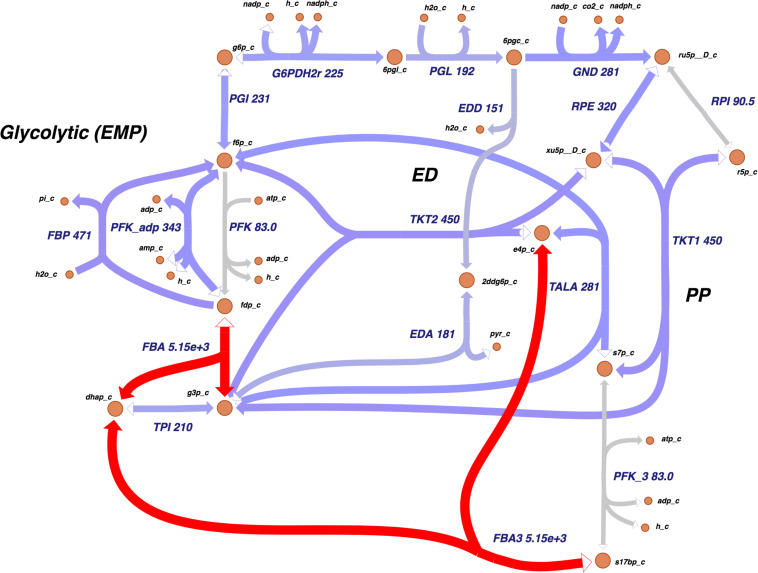
The carbohydrate utilization pathways of Xpm show a high activity at the transcriptional level. Transcriptomic data showed that Xpm has a high activity in the flux balance analysis (gene 1185660.4.peg.3367) and FBA3 (gene 1185660.4.peg.3367) reactions. The data of Xpm CIO151 EV are shown, but similar results were found for Xpm CIO151 ΔrpfCGH-EV. The levels of transcription are shown next to the name of the reaction. Transcriptomic abundances were mapped into Escher maps. The purple color in the maps corresponds to low abundance and the red color to high abundance. The median of the transcript abundances (FPKM) defined the middle point of coloring (between red and purple). Therefore, values below the median are colored purple and those above the median are colored red. When in the reaction rule two or more genes are strictly necessary (AND Boolean rule), the mean of the abundance was calculated. The thickness of the lines is proportional to the abundance of the transcripts involved in the given reaction. Entner–Doudoroff (ED), pentose-phosphate (PP), and Embden–Meyerhof–Parnas (EMP). Constructed in Escher (King et al., 2015).